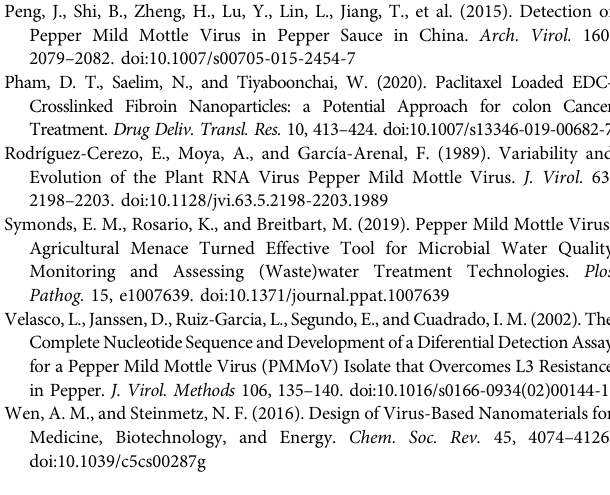
Supplementary Figure 1 | Synthesis and characterization of FA-PEG. (A) Synthesis route of FA-PEG. (B) 1 H NMR spectra of FA, PEG and FA-PEG. Supplementary Figure 2 | Intracellular fl uorescence intensity, measured by fl ow